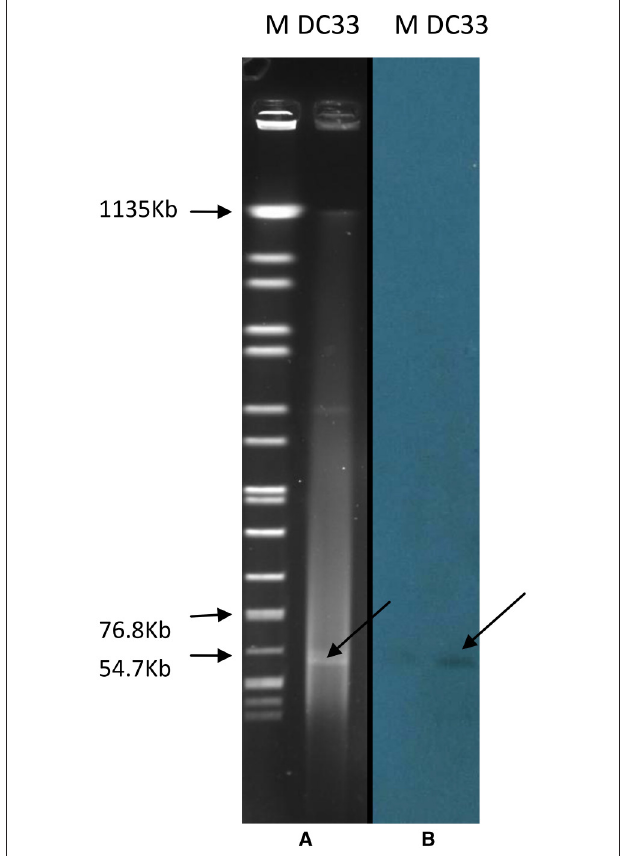
FIGURE 1 | S1-digested plasmid DNA of E. coli DC33 (A). Southern blot hybridization with bla NDM - 13 of E. coli DC33 (B). M, Salmonella serotype Braenderup strain H9812.